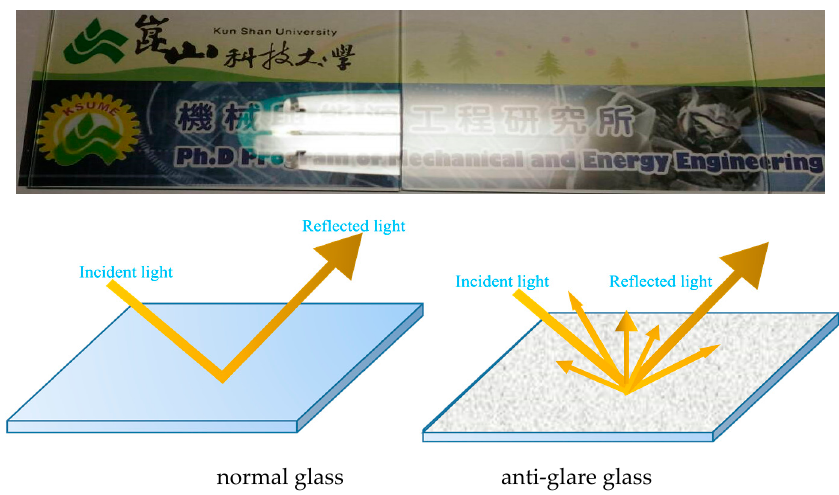
Figure 1. Schematic diagram of light path for normal and anti-glare glass.